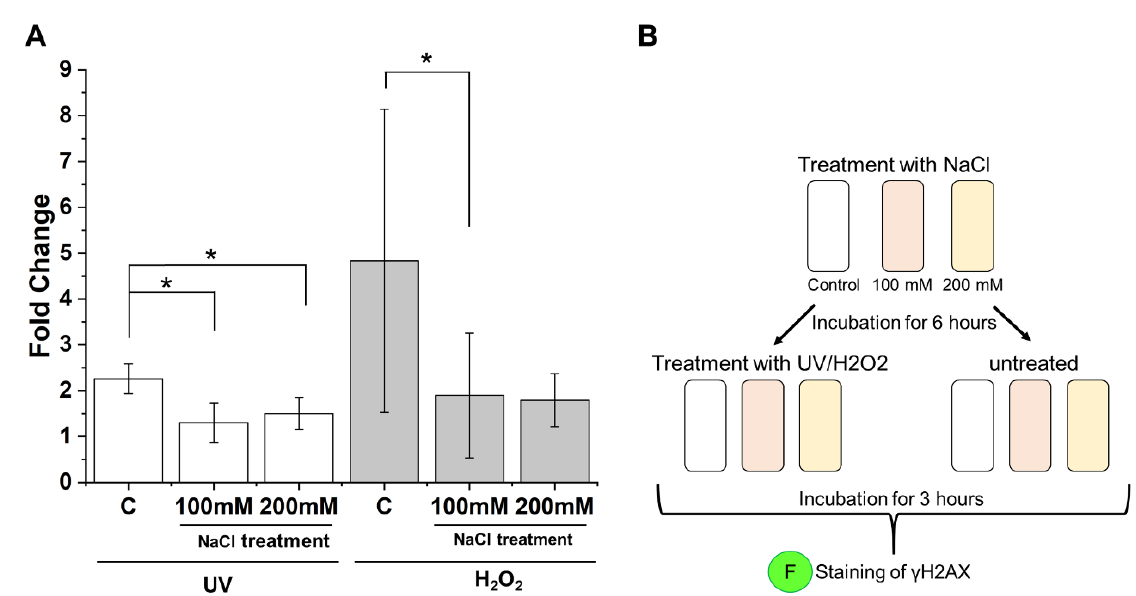
Figure 4. γH2AX identification in costress model. ( A ) Fold change of γH2AX positive cells after UV radiation ( n = 4) or H 2 O 2 treatment ( n = 8) in untreated control cells or cells cultured under osmotic stress conditions prior to radiation or H 2 O 2 treatment. Fold changes were calculated by comparing irradiated or H 2 O 2 treated cells with untreated cells. * = p < 0.05. ( B ) Experimental setup for costress model. Cells were treated with NaCl (100 mM or 200 mM) or cultured in normal medium (=Control). Cells were either radiated with UV (10 min 75 W (4500 mJ/cm 2 )), treated with H 2 O 2 (300 µM), or were untreated 6 h after incubation . Cells were subsequently stained for γH2AX after 3 h of incubation and γH2AX positive cells were identified using image analysis.